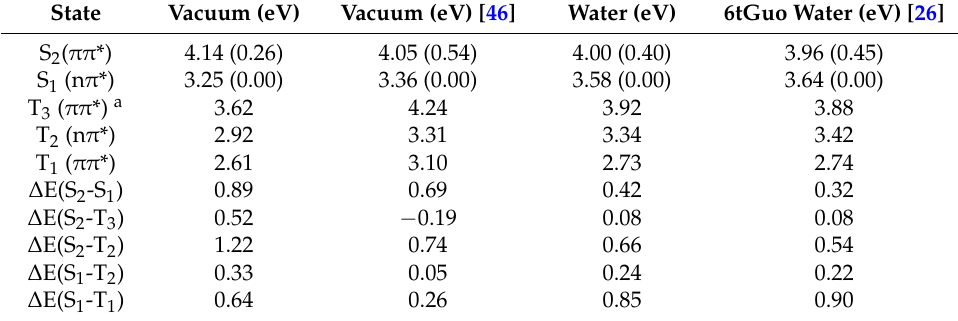
Table 1. Vertical excitation energies for 6tGua in vacuum and in water environments, and for 6tGuo in water [26], computed at the TD-PBE0/IEFPCM/6-311++G(d,p) level of theory. Oscillator strengths are provided in parentheses. Vertical excitation energies computed at the MS-CASPT2//CASSCF(14,12)/ANO-L level of theory [46] are also given for comparison. State Vacuum